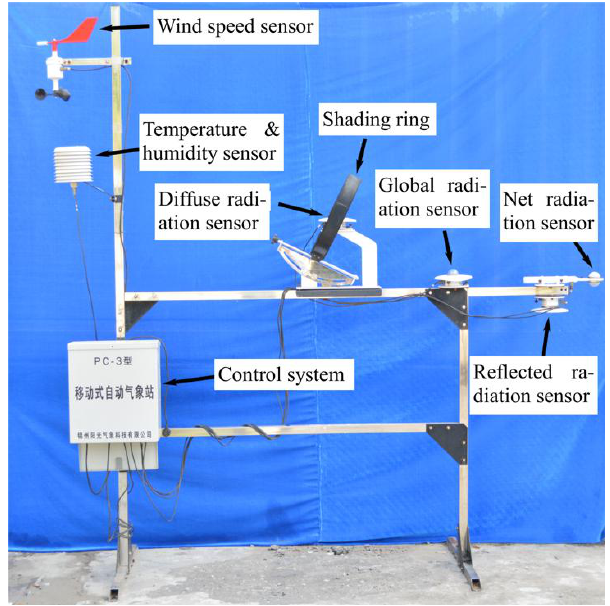
Figure 1. Automated meteorological station.